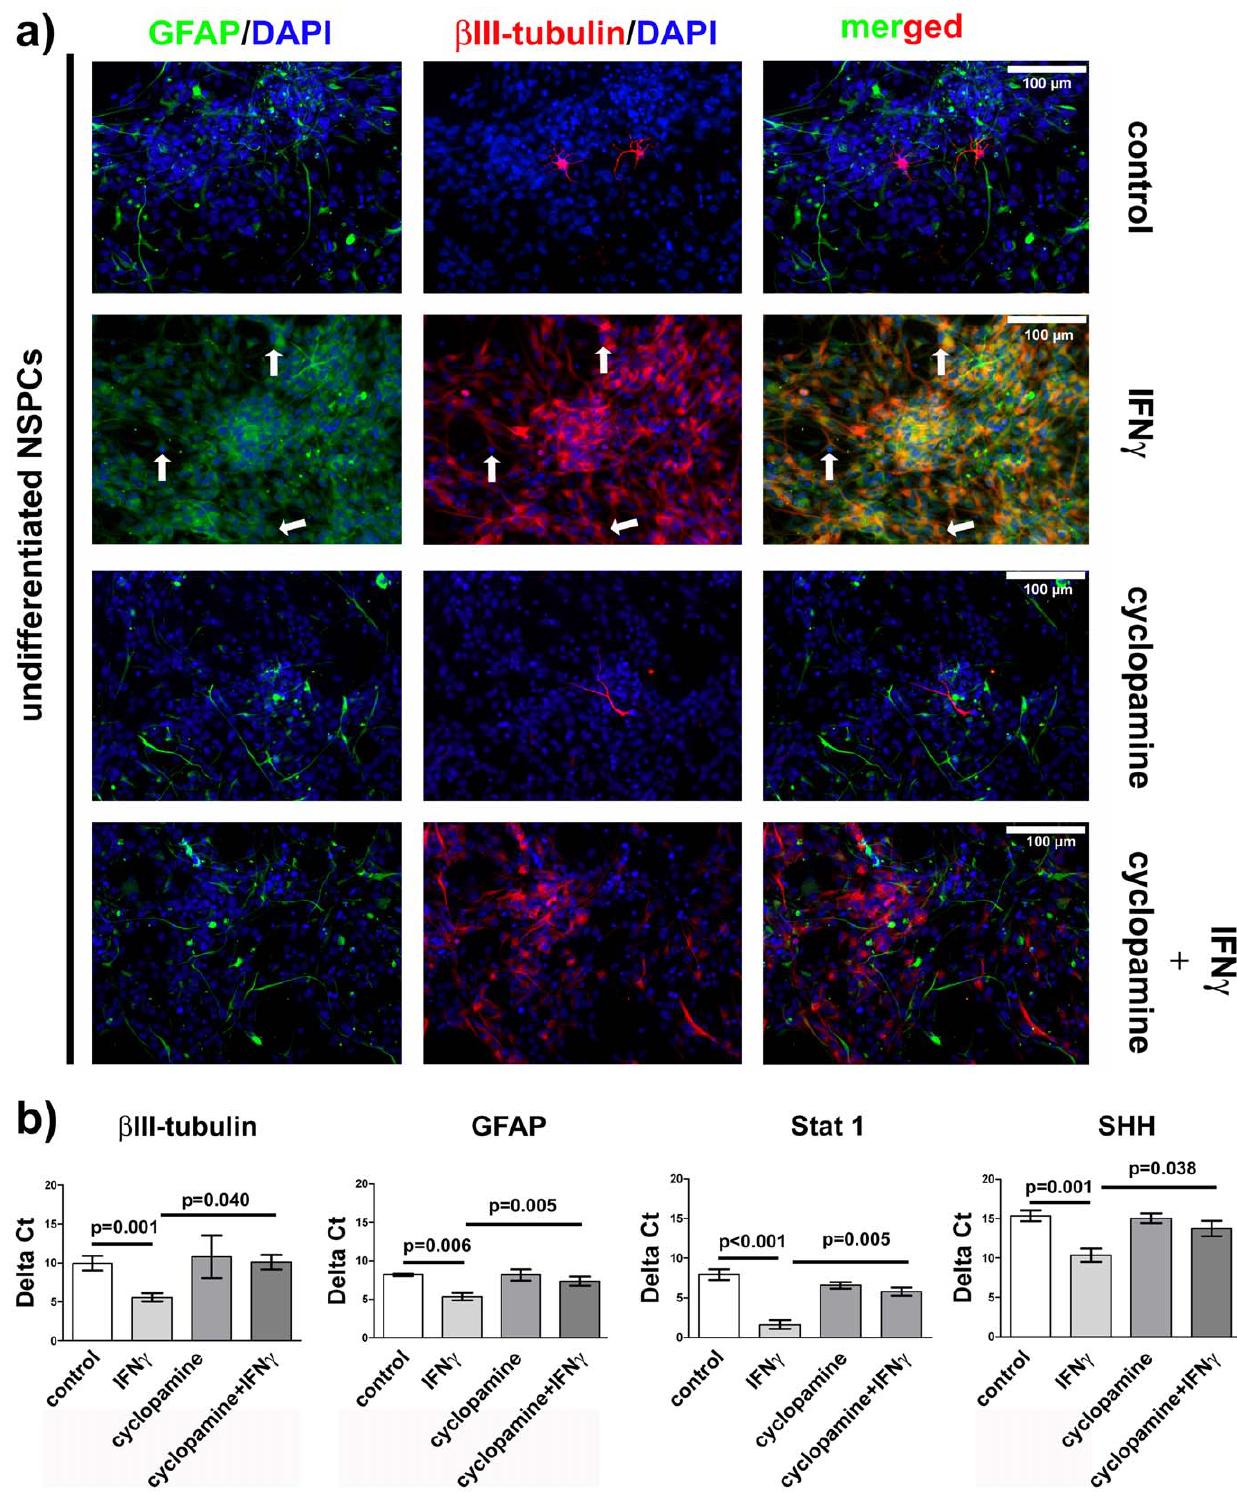
Figure 1. Effects of IFN c in NSPCs are blocked by cyclopamine. In Figure a: Photomicrographs of undifferentiated murine NSPCs are given. The left panel shows an immunocytochemical staining for GFAP, the middle panel for b III-tubulin and the right panel shows both. The first row represents the control, and the second row represents the IFN c -treated cells. The third row shows cells that are treated with cyclopamine alone, and the fourth row shows cells treated with both substances. In Figure b: The results of the real-time quantitative PCR experiments for GFAP, b III-tubulin, Stat 1 and SHH gene expression are depicted. Delta CT values are means + / 2 standard error of mean (SEM). Independent experiments were repeated for three times in triplicate.